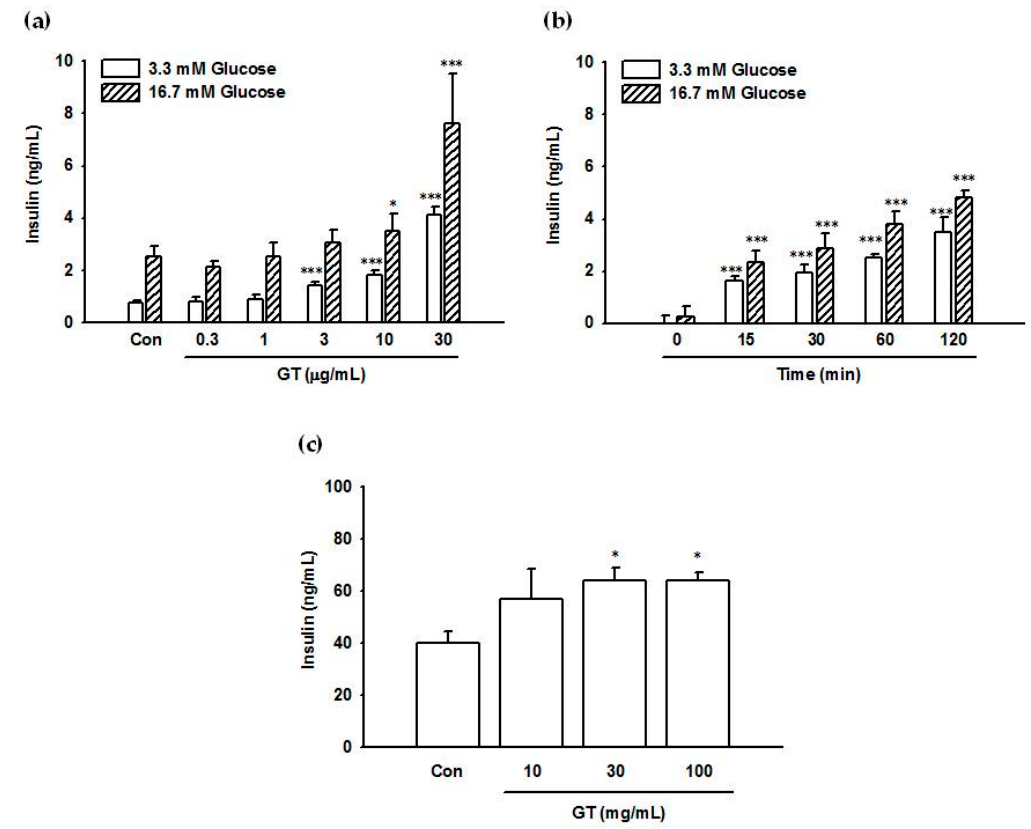
Figure 1. Effects of gintonin on insulin secretion from INS-1 cells and rat pancreatic islets. ( a , b ) Cells